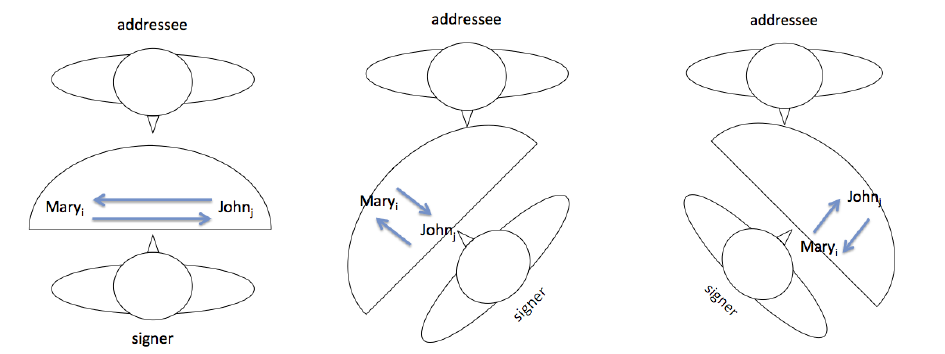
Figure 6. Fixed referential space (left) versus shifted referential space (middle and right) (based on Figure 1.9 in Poizner et al. 1987, p.